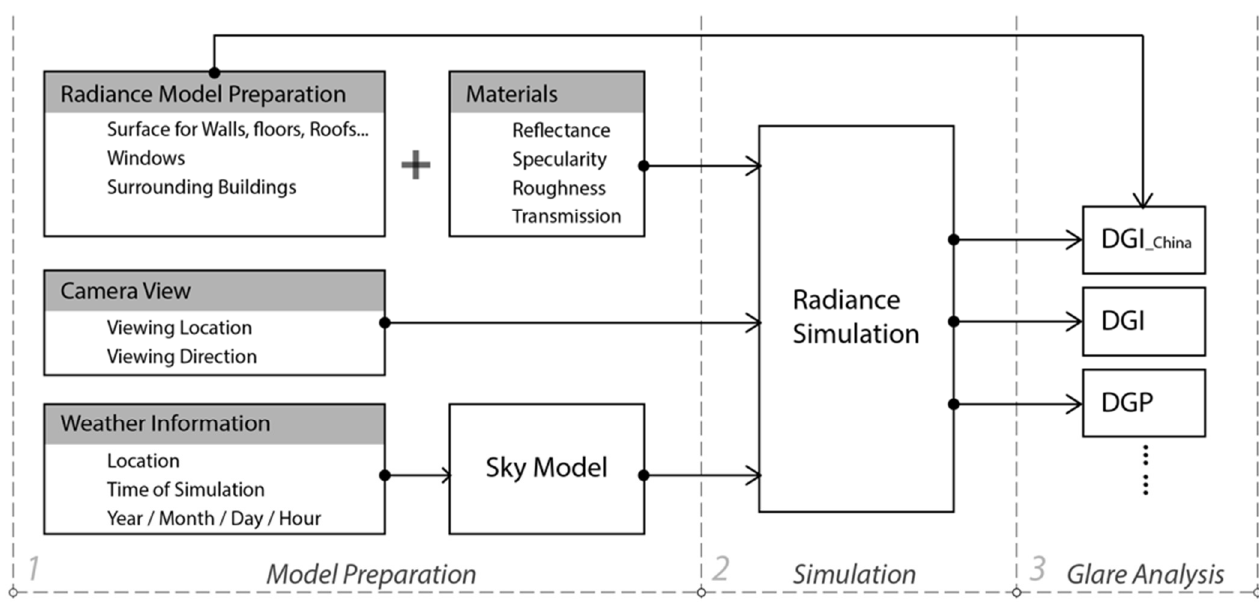
Figure 3. The computational workflow for the integration from the model preparation to glare analysis.